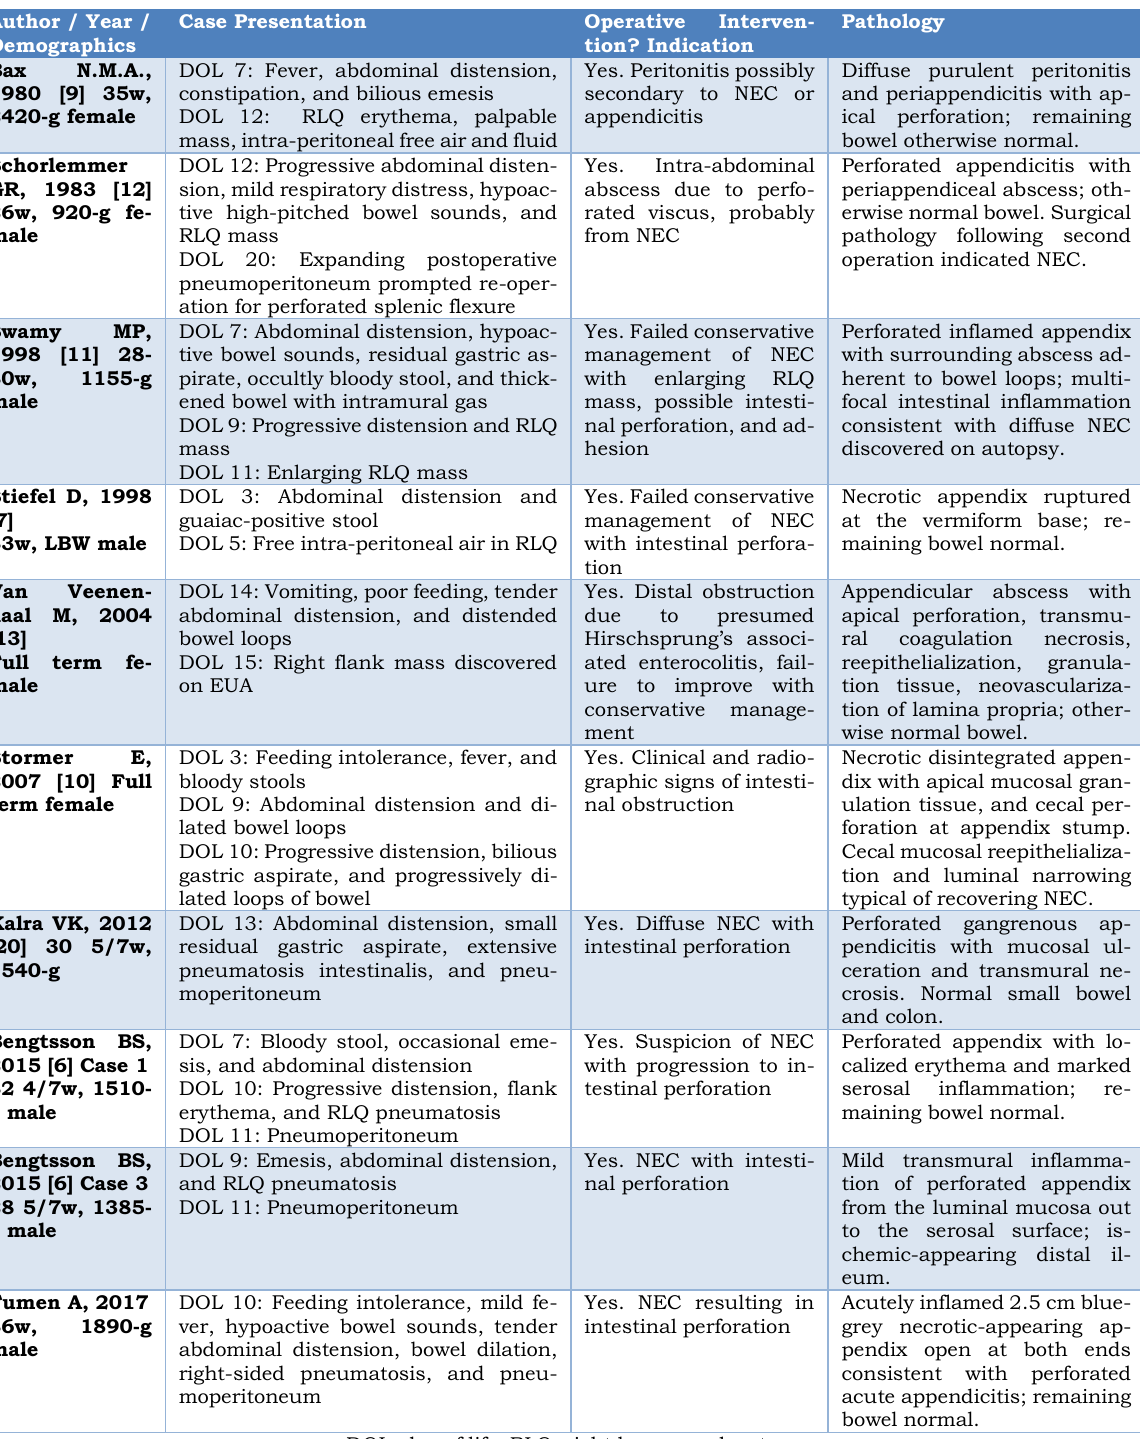
Table 1: Reported cases of neonatal perforated appendicitis with necrotizing enterocolitis as an underlying etiology Author / Year /